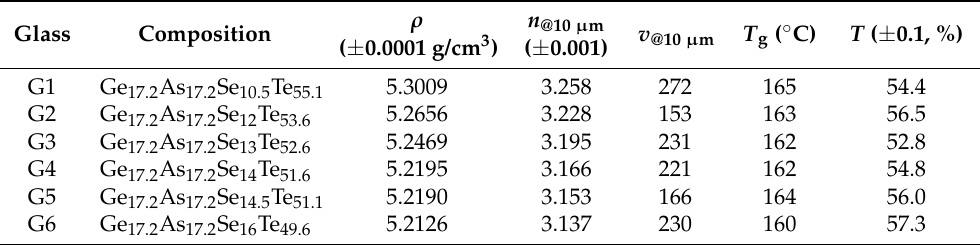
Table 1. Glass composition, density ( ρ ), refractive index ( n ), Abbe number ( v ), glass transition temperature ( T g ), and transmittance ( T %) of the GRIN lens at 10 µ m.